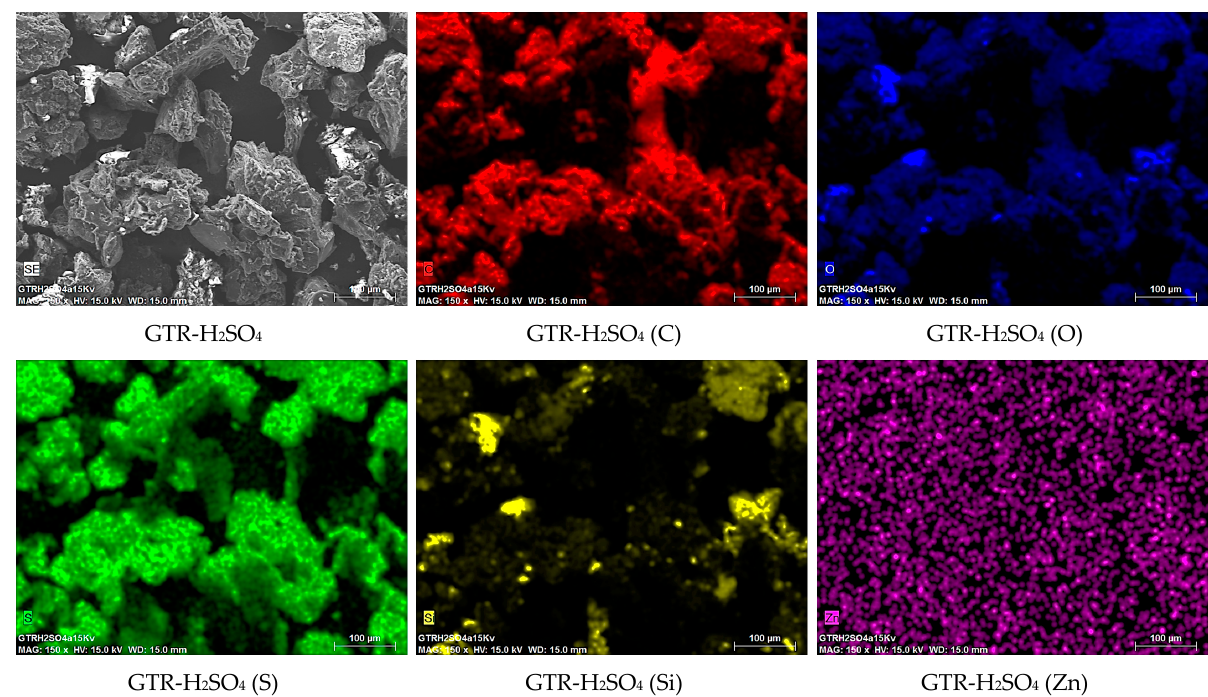
Figure 3. Energy dispersive X-ray (EDX) elemental mapping of m-GTR sample treated with H 2 SO 4 at a magnification of 150×.